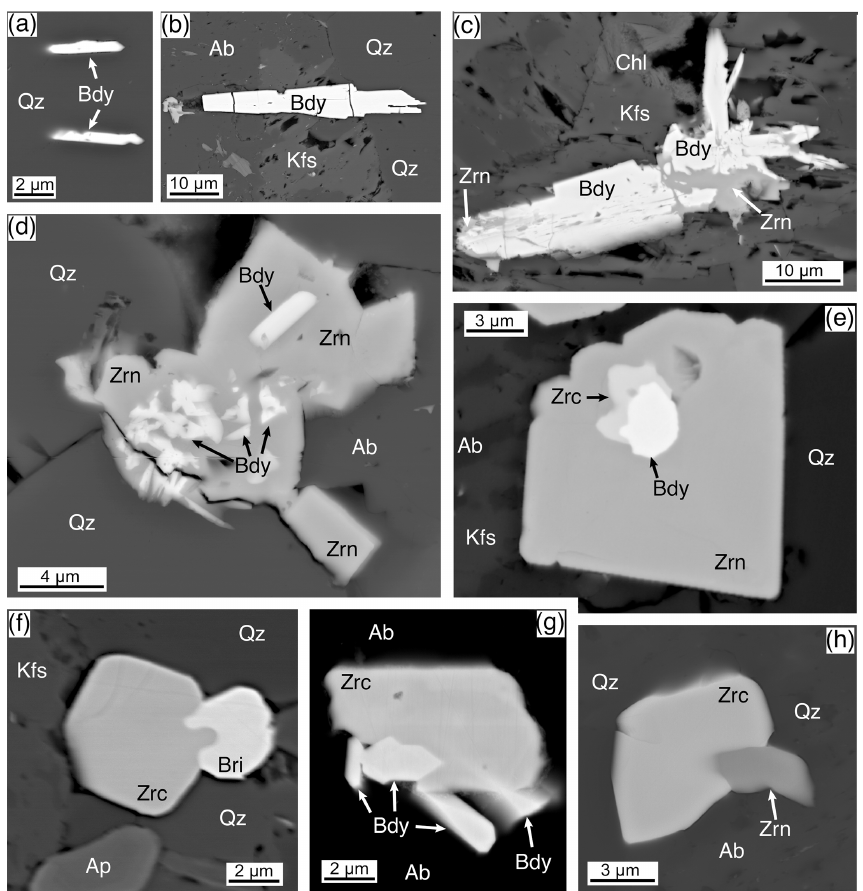
Figure 10. Baddeleyite and zirconolite, BSE images. (a) Two doubly terminated blades of baddeleyite (Bdy) enclosed in quartz (Qz). Rum, Western Granite, sample RUM. (b) A 50µm blade of baddeleyite (Bdy) imbedded in quartz (Qz), albite (Ab), and K-feldspar (Kfs). A small portion on the left side of the blade has been plucked out. Rum, Western Granite, sample RUM. (c) A 50µm baddeleyite (Bdy) blade, in part with radiating blades, in K-feldspar (Kfs) and chlorite (Chl). Zircon (Zrn) is replacing the baddeleyite on the lower-right and upper-left ends. Rum, Western Granite, sample RUM. (d) A residual mass of baddeleyite (Bdy) that has been replaced and overgrown by zircon (Zrn), enclosed by quartz (Qz) and albite (Ab). Rum, Western Granite, sample RUM. (e) Small ∼ 1µm crystals of zirconolite (Zrc) growing on a 3µm baddeleyite (Bdy), both enclosed by a 17µm euhedral zircon (Zrn) enclosed by quartz (Qz), albite (Ab), and K- feldspar (Kfs). Ardnamurchan, Grigadale Granophyre, sample 13138. (f) A 6µm euhedral zirconolite (Zrc) with a coeval, at least on the rim, britholite-(Ce)(Bri). Surrounded by quartz (Qz) and K-feldspar (Kfs) with a zoned apatite (Ap) to the lower left. Ardnamurchan, Grigadale Granophyre, sample 13138. (g) An 8µm subhedral zirconolite (Zrc) with adjacent and embedded baddeleyite (Bdy), enclosed by albite (Ab). Ardnamurchan, Granophyre, Centre 2, sample 14724. (h) A 10µm subhedral zirconolite (Zrc) that has partially grown over a 3µm zircon (Zrn), enclosed by quartz (Qz) and albite (Ab). Ardnamurchan, Grigadale Granophyre, sample